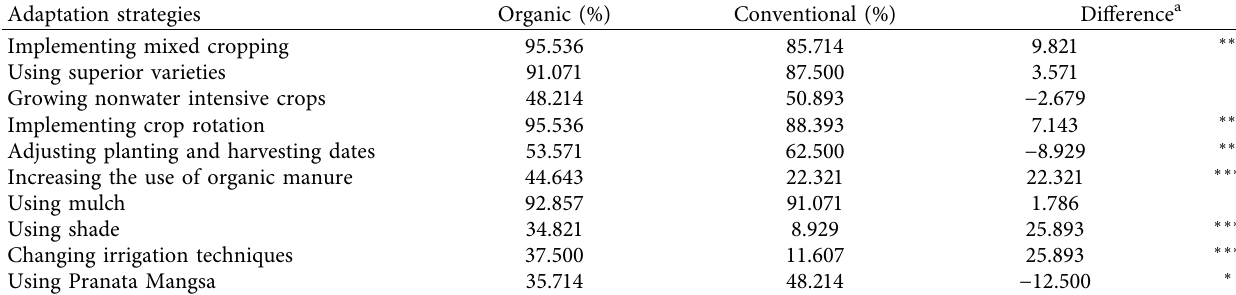
Table 4: Climate change adaptation strategies of organic and conventional vegetable farmers in